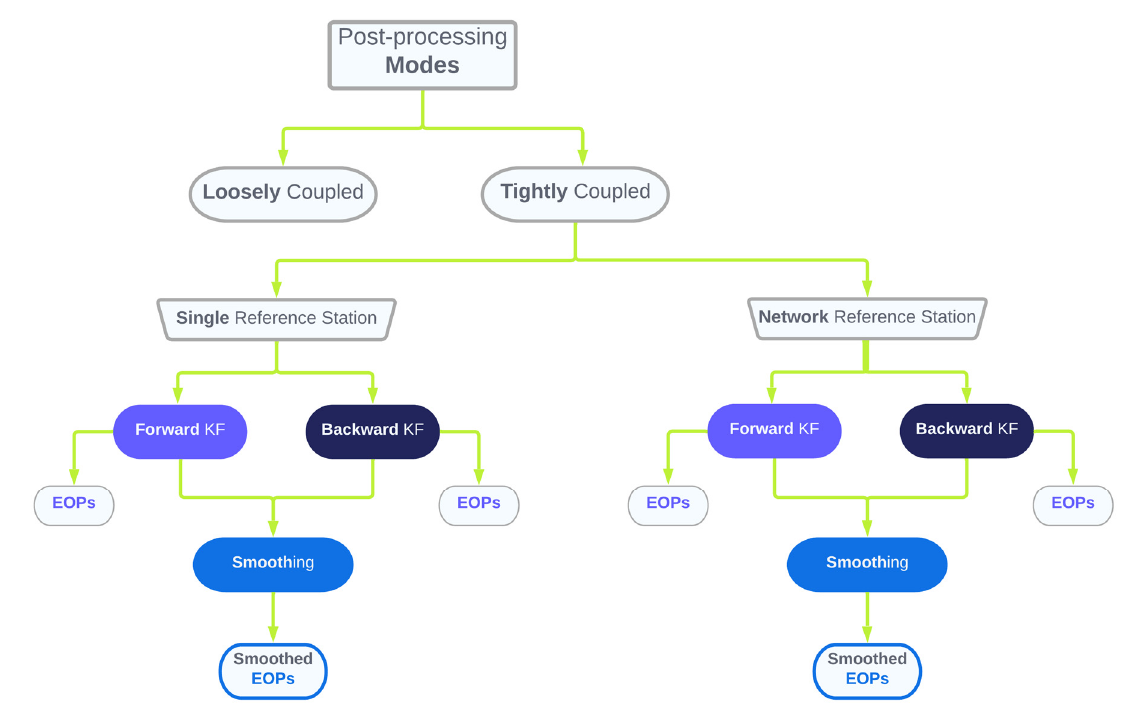
Figure 4. A schematic view of the post-processing sequences used for GNSS/IMU integration